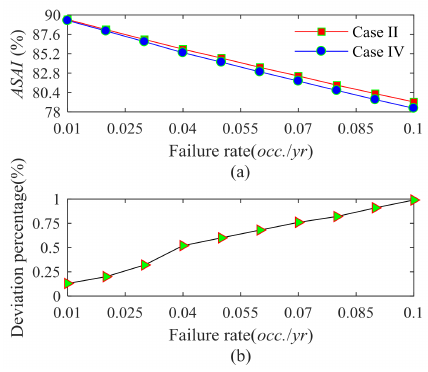
Figure 7. ( a ) Average system availability index (ASAI) changes with failure rate; ( b ) Deviation percentage of ASAI index between chain-type I and chain-type II.